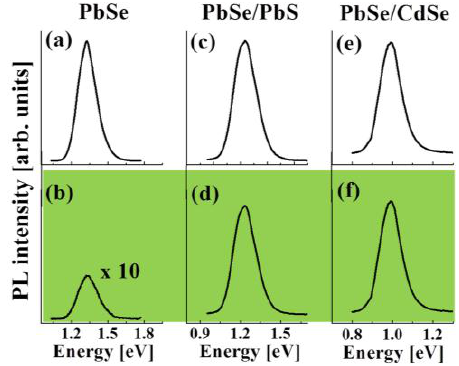
Figure 15. Comparison of the cw-PL spectra of PbSe ( R C = 1.1 nm), PbSe/PbS ( R S /R C = 1.6/1.1 nm), and PbSe/CdSe ( R S /R C = 1.9/1.6 nm) QDs recorded at RT under air-free conditions ( a , c , and e , respectively) and after exposure to air for 20 min ( b , d , and f ,